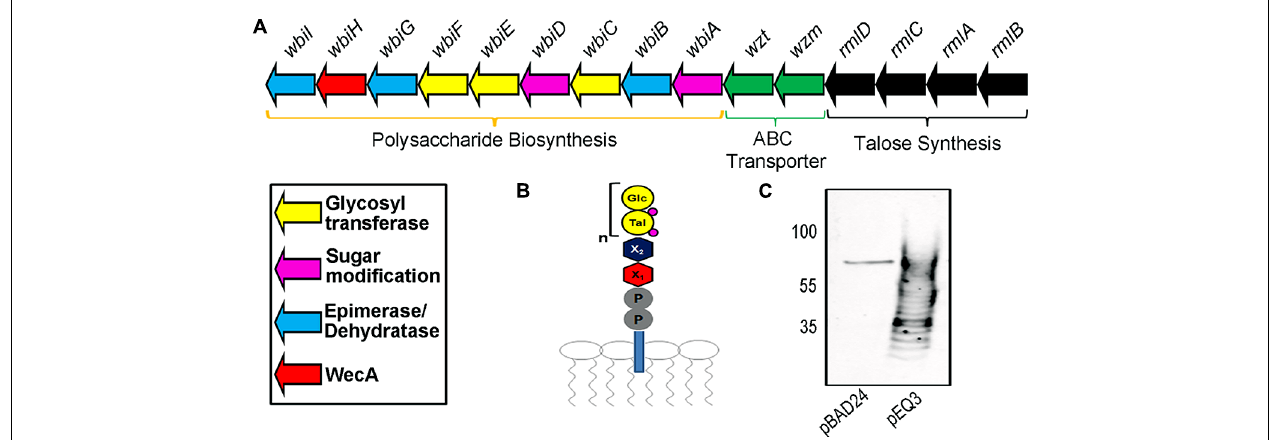
FIGURE 1 | Description of Burkholderia pseudomallei O-polysaccharide II (OPSII) cluster. (A) Representation of the required 15 genes for the synthesis of OPS II and predicted functions. (B) Expected glycan intermediate structure